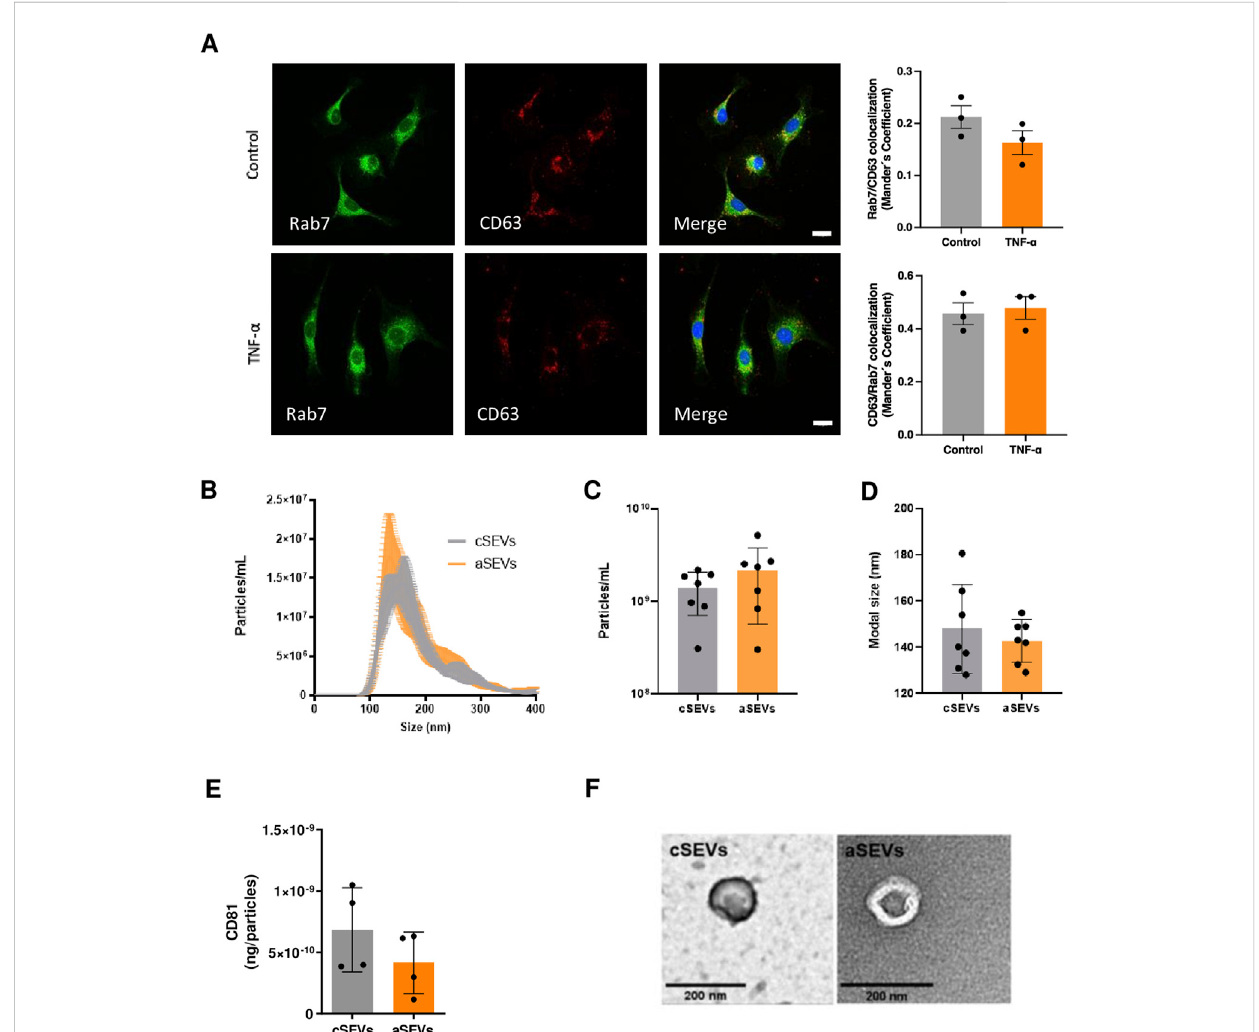
FIGURE 2 TNF- α does not affect production, expression of surface markers, size or morphology of endothelial-derived SEVs. (A) Immuno fl uorescence showing co-localization of Rab7 and CD63 in endothelial cells treated with or without TNF- α (n = 3) Scale bar: 20 μ m. (B) Size distribution (n = 7), (C) concentration (n = 7), (D) modal size (n = 7) determined by Nanoparticle Tracking Analysis. (E) CD81 expression determined by ELISA (n = 4), and (F) morphology of endothelial small extracellular vesicles treated with (aSEVs) or without (cSEVs) TNF- α assessed by electronic microscopy. Scale bar: 200 nm. Mean ±